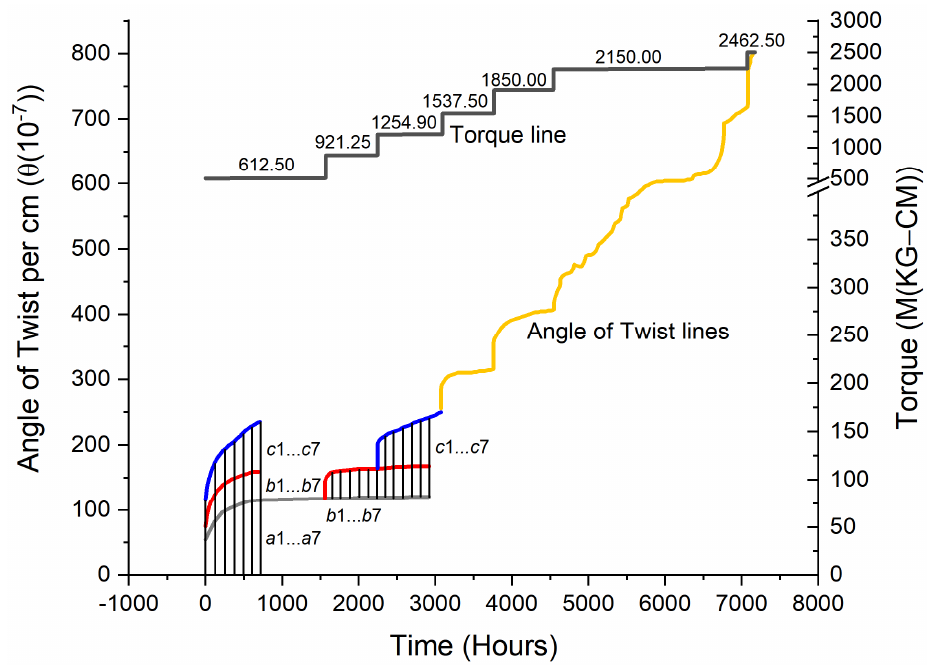
Figure 2. SL creep curve for sandstone and its conversion to RL creep curve [20]. The colors of angle of twist per cm–time lines represent the following: gray line, under 612.50 KG-CM torque; red lines, under 921.25 KG-CM torque; blue lines, under 1254.90 KG-CM torque; yellow line, under other later torque levels.